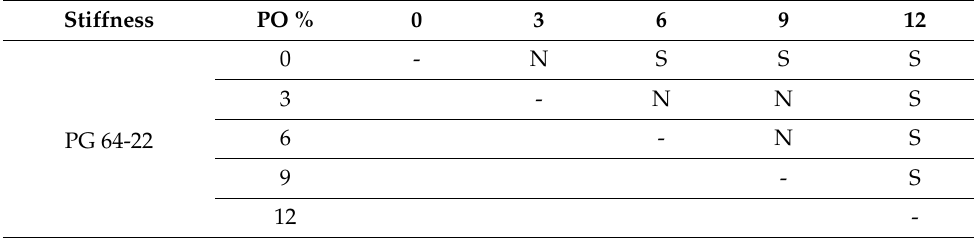
Table 9. Statistical analysis results of the stiffness as a function of processed oil content − 24 ◦ C ( α = 0.05).